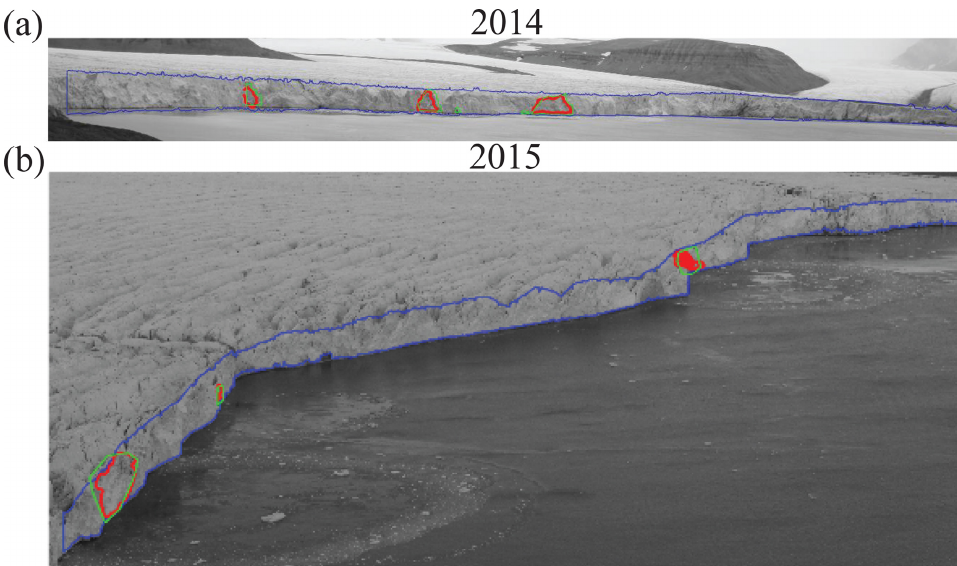
Figure 6. Example of mask delineation (blue), automatic calving detection (red) and manual calving detection (green) for (a) 2014 (2 Septem- ber, 11:45) and (b) 2015 (1 September,